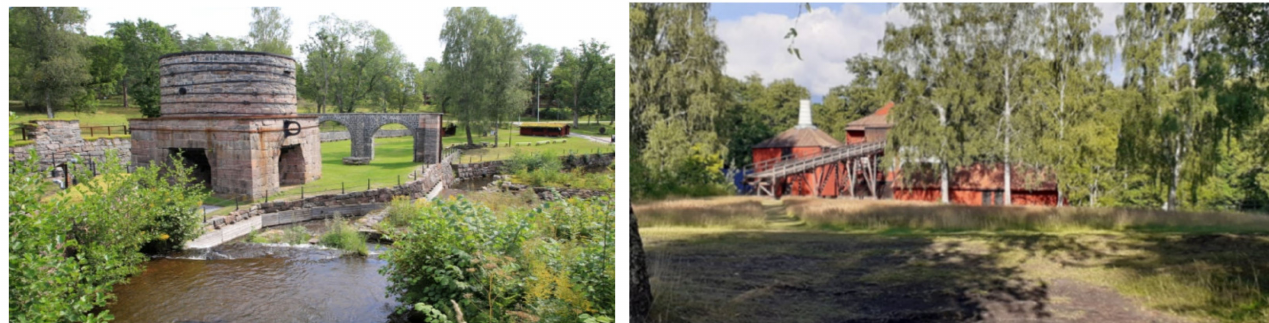
Figure 14. Stopping places in the eco-park with the remains of industrial structures blended in and complementing the landscape. On the left, the Borgviks blast furnace—built in 1863–1865 is part of a post-industrial park using the natural environment [38]. On the right—in place of the original furnace, a new blast furnace was built in 1882, which has survived to this day with a water turbine, boiler, steam engine and cylinder blower. 2008–own